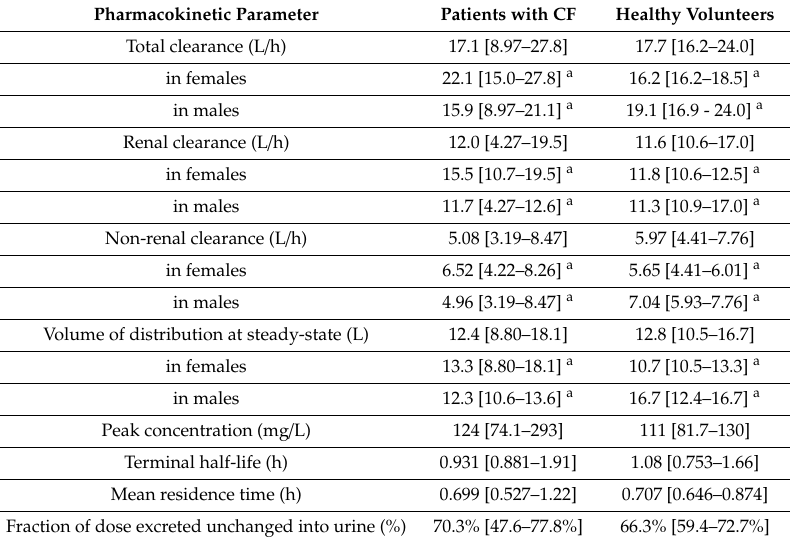
Table 2. Unscaled pharmacokinetic (PK) parameters from non-compartmental analysis (data are median [range]). These PK parameters were calculated based on total cefotiam concentrations in